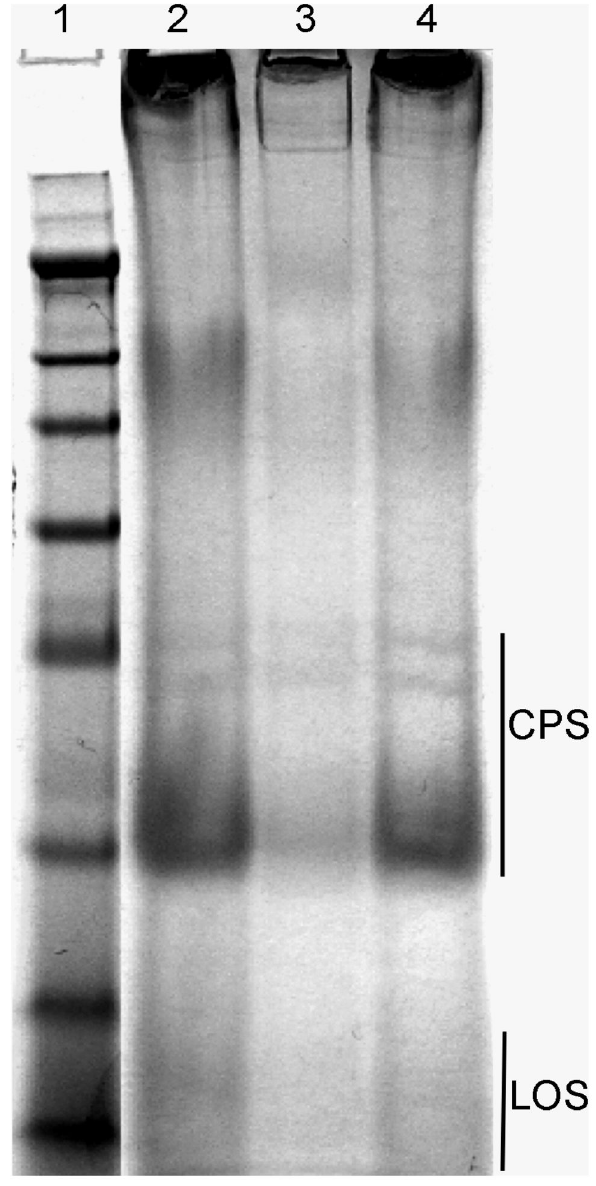
Figure 6. The effect of Cj1411c gene deletion on CPS production. Alcian blue stained CPS of C. jejuni 81-176 wild type (lane 2) was compared with the CPS extracted C. jejuni 81-176 Δ Cj1411c (lane 3) and C. jejuni 81-176 Δ Cj1411c :: Cj1411c (lane 4). doi: 10.1371/journal.pone.0075534.g006 enzymes are known to be integral membrane proteins [21].